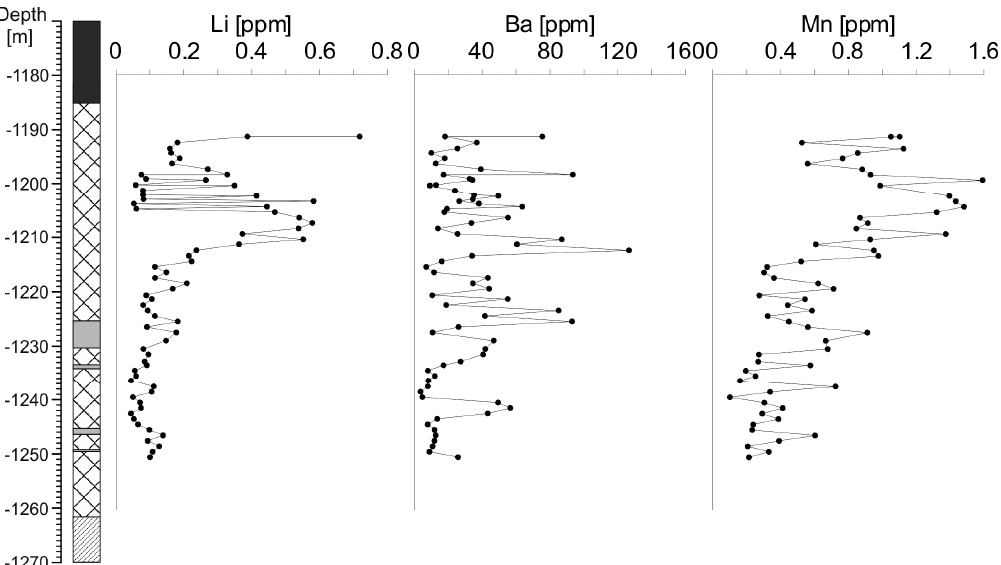
Figure 14. Distribution of calcium, strontium, and caesium in Lotsberg salt profile. Explanation in Figure 12.